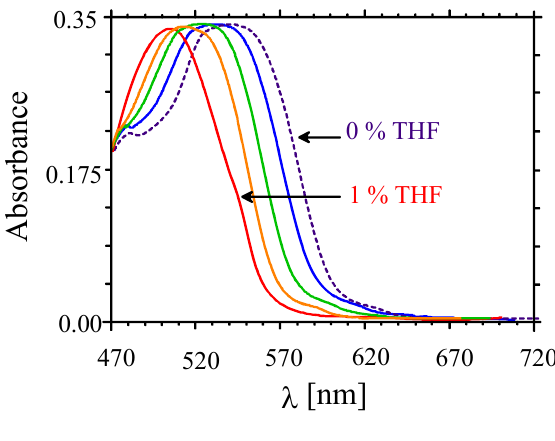
with increasing concentration of solvent max